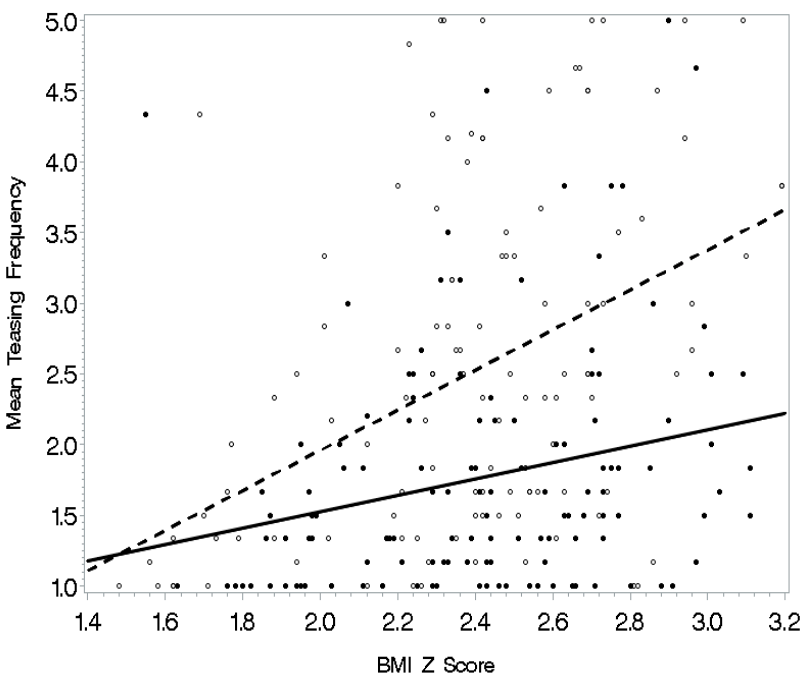
Figure 4. Self-esteem as a moderator: For adolescents with higher self-esteem (solid line), there was less of a relationship between BMI z-score and teasing; this relationship was stronger for those with lower self-esteem (dashed line).